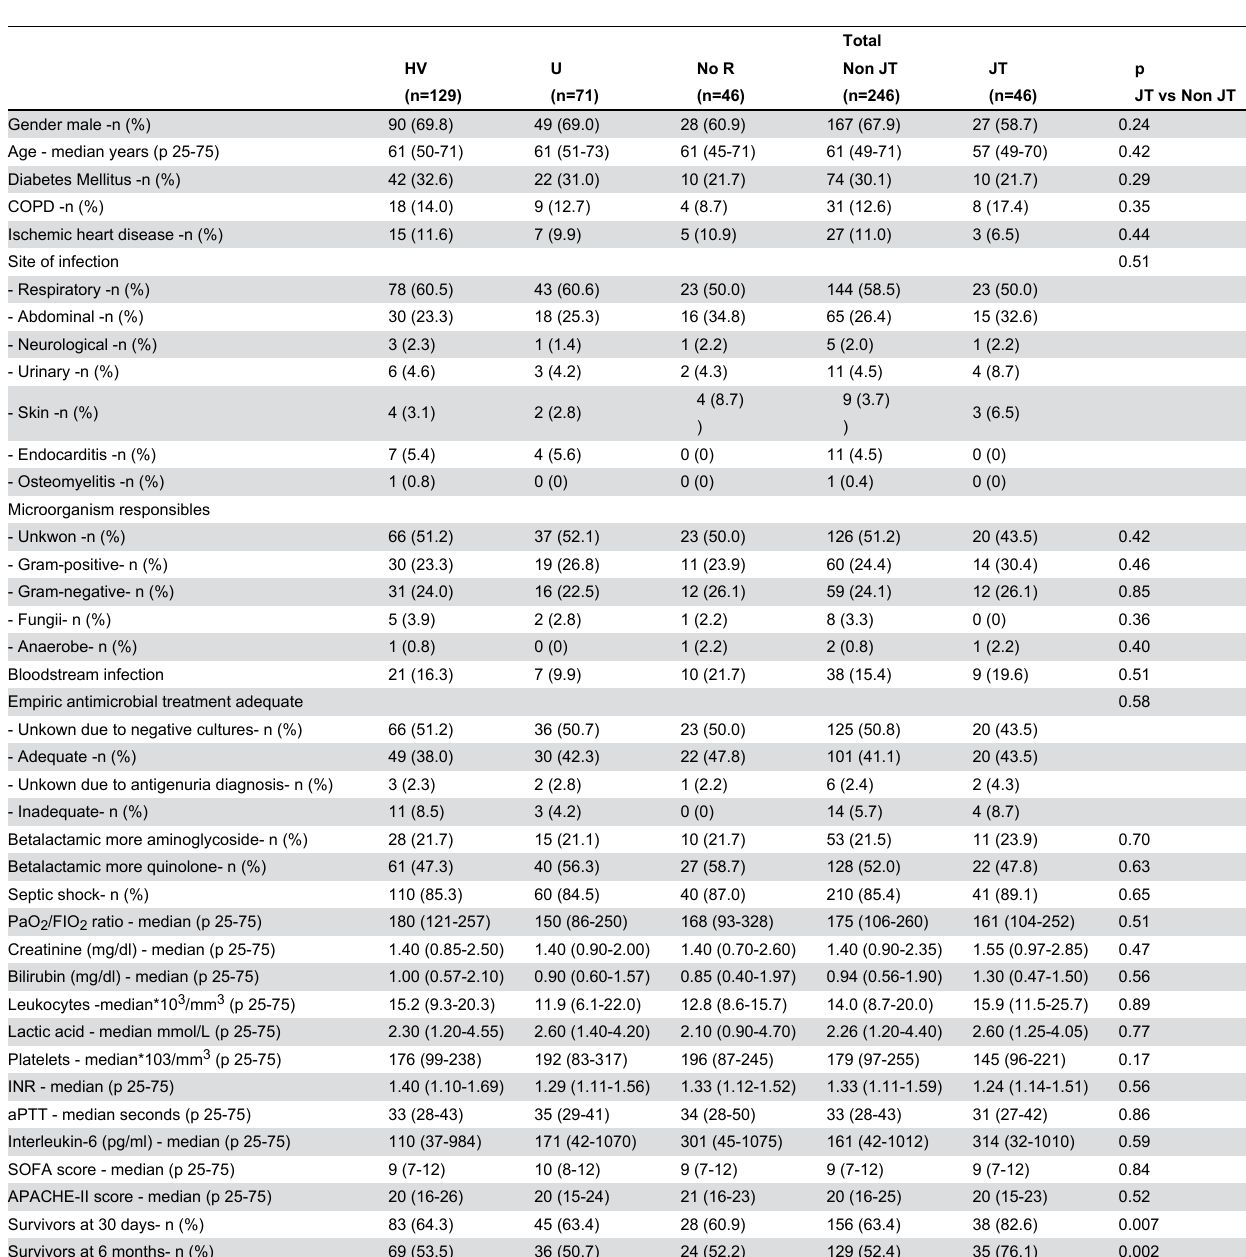
Table 1. Patients’ demographic and clinical characteristics according to mtDNA haplogroups of the 292 patients of global cohort (first and second cohort